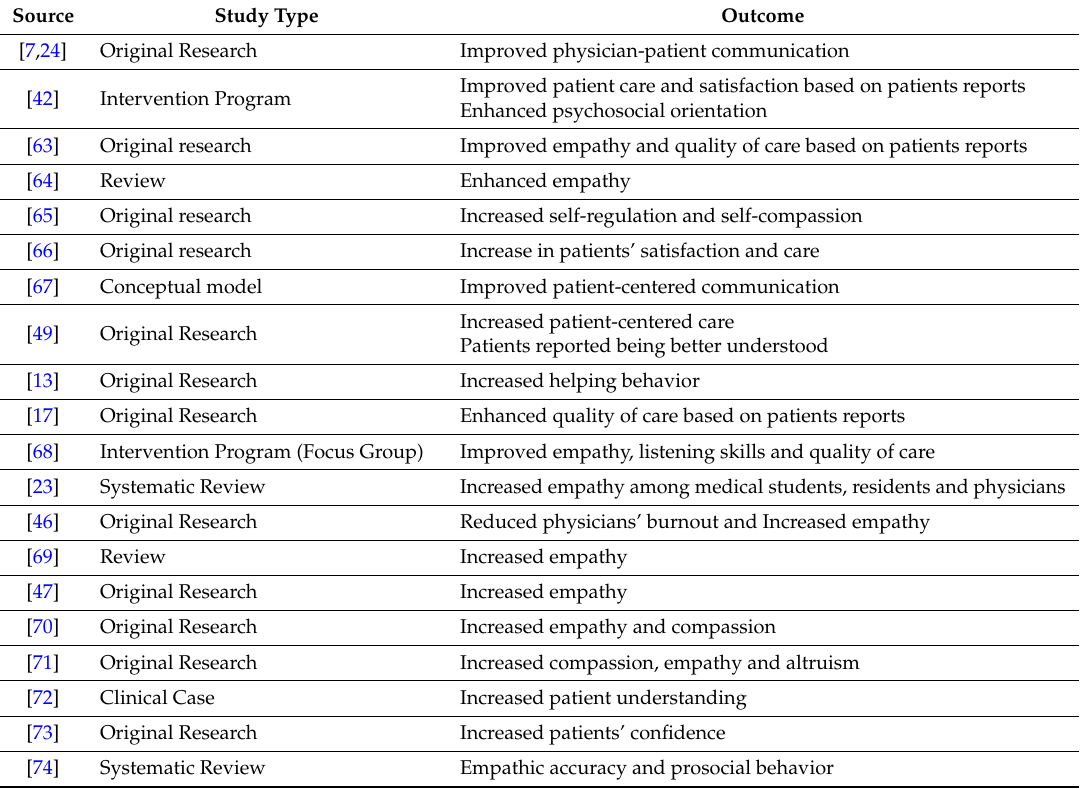
Table 1. Studies on the influence of Mindfulness and Compassion-based interventions for improving physician-patient